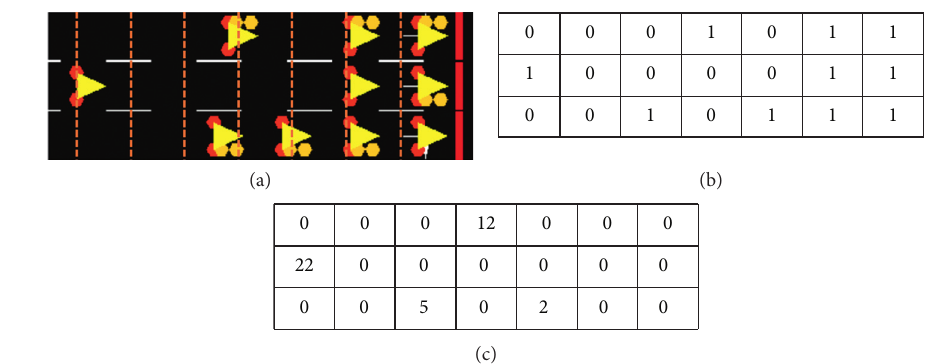
Figure 3: Flowchart of information transfer between modules.